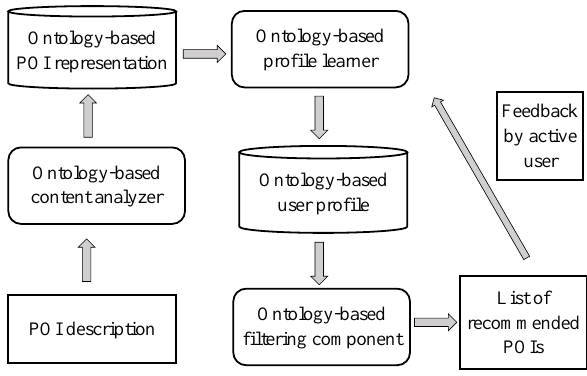
Figure 1. The architecture of the proposed ontology-based recommender system